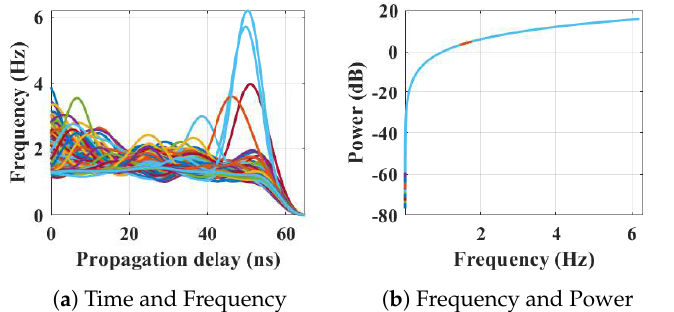
Figure 5. The relationship between propagation delay, activity frequency, and received power from the radar responses obtained while the person is plumping a cushion has been considered as C2 in classification